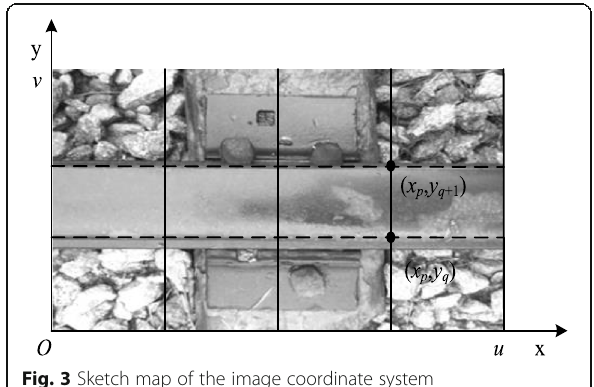
Fig. 3 Sketch map of the image coordinate